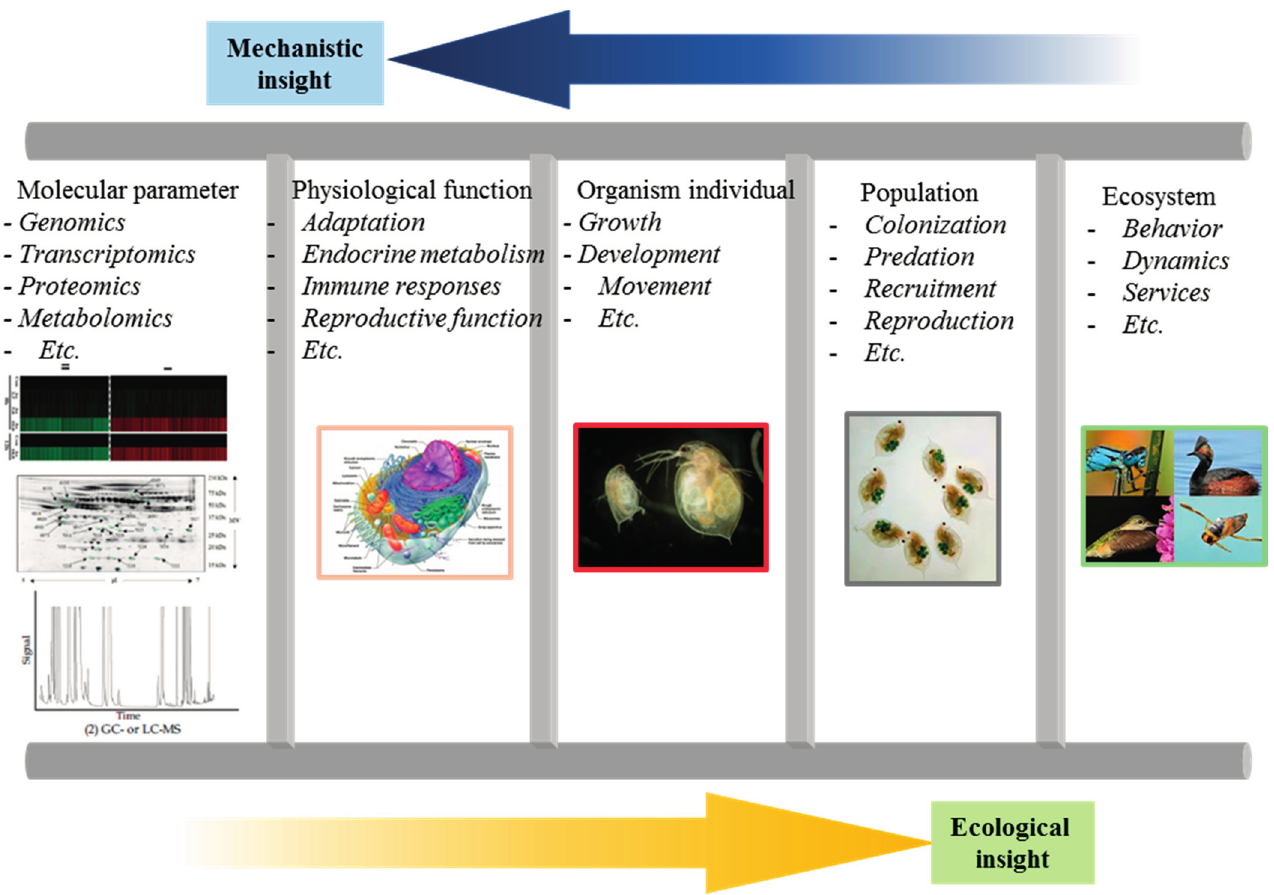
Figure 2. A scheme representing multilevel-framework for ecotoxicogenomic studies at multiple levels ranging from molecular, physiological, organismal, and population in